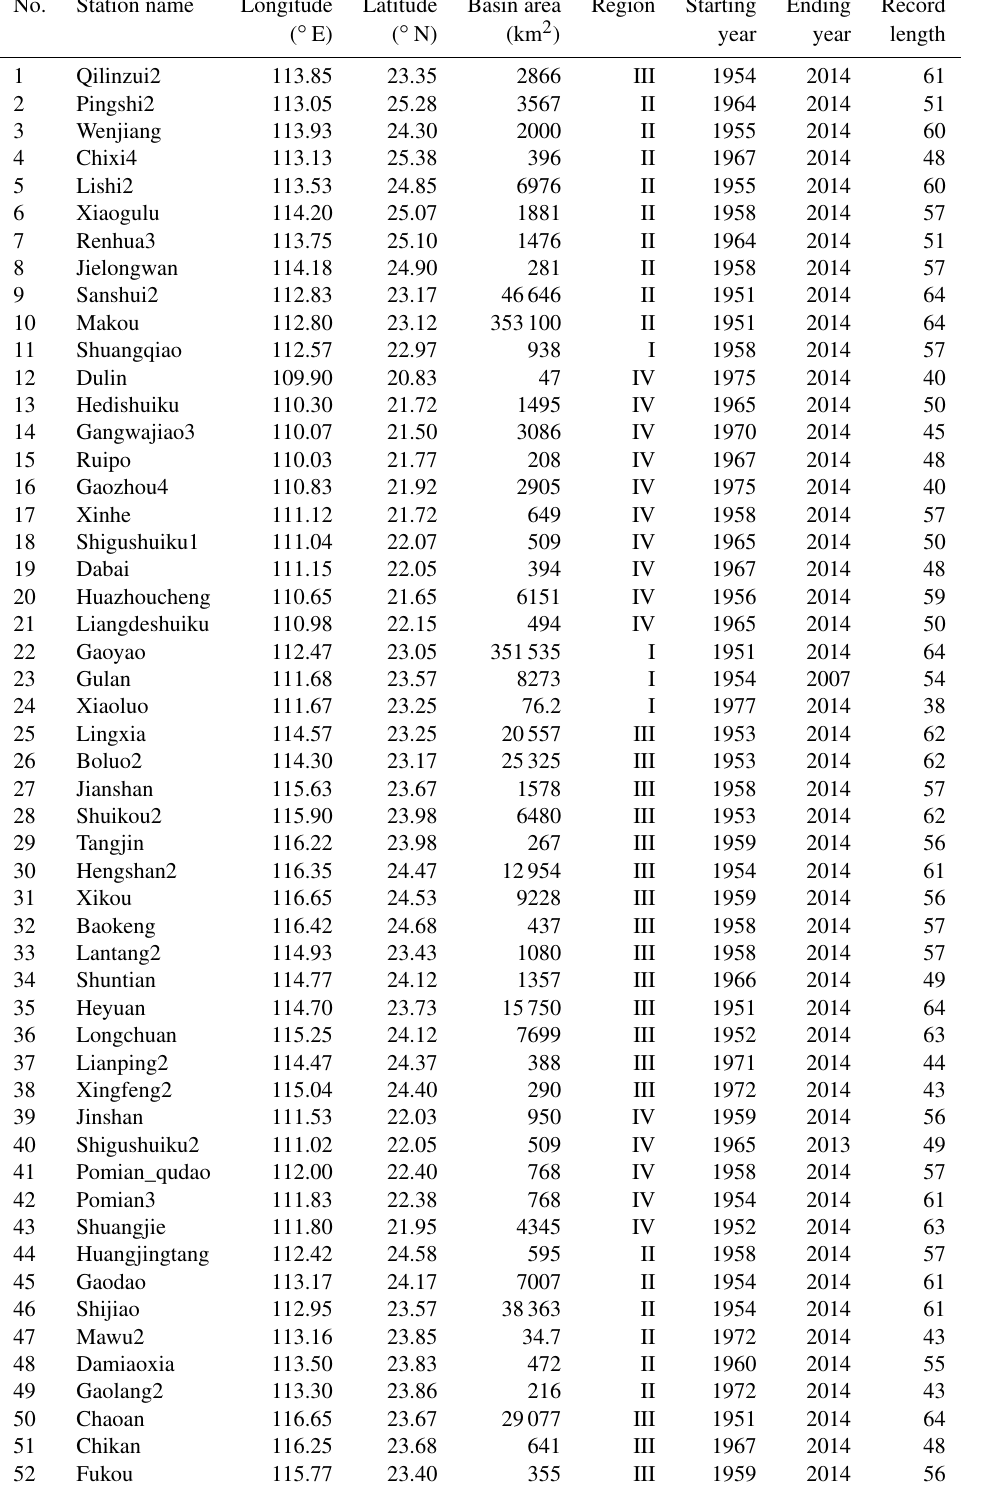
Table 1. Detailed information of hydrological stations in this study.